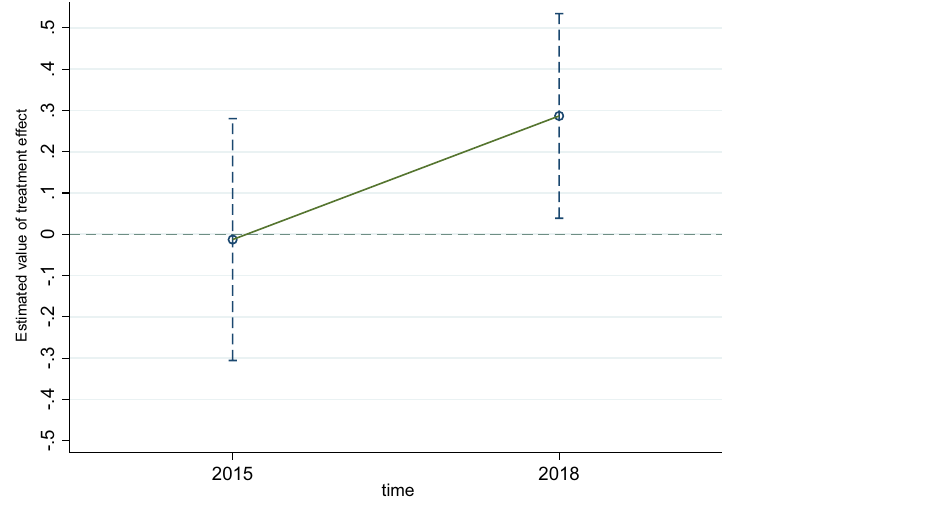
Figure 2. Parallel trend test—urban residents.